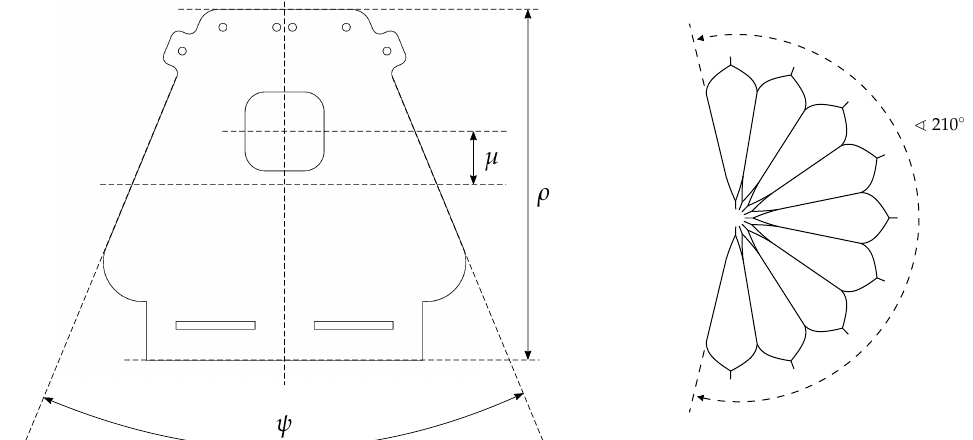
Figure 5. The left figure shows the top view of a single actuator layer. The deformation behavior mainly depends on the actuator height ρ and the off-center distance µ . Choosing the angle ψ > 0 increases the footprint of the actuator and therefore the lateral stability during inflation such that the actuator does not bend sideways. The following parameter values are used for the final design: ρ = 89mm, µ = 13.6mm, and ψ = 45°. The figure on the right shows the side view of an inflated actuator. The nine cushions result in a total angle of approximately 210°. The outer arc length of the actuator when fully inflated is approximately 340mm, compared to a thickness of 18mm when the actuator is fully